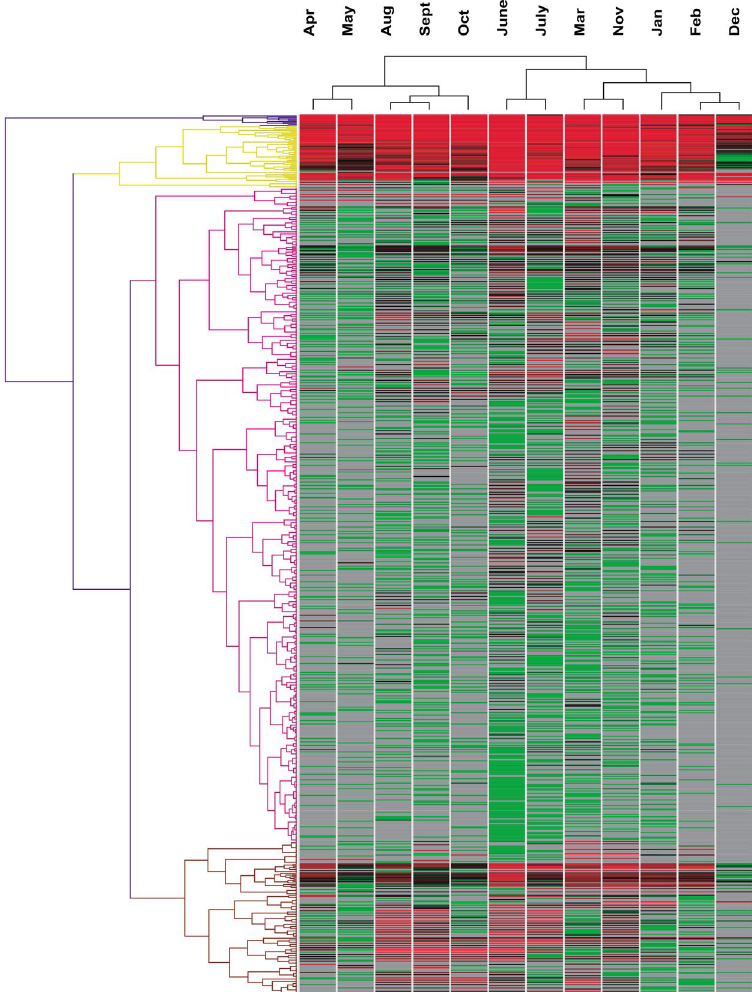
Figure 4. Heatmap illustrating different genera percentage by 12 months. Hierarchical cluster was calculated for the month and genera. More details of different genera were listed on the Supplementary Tables S2–S12.